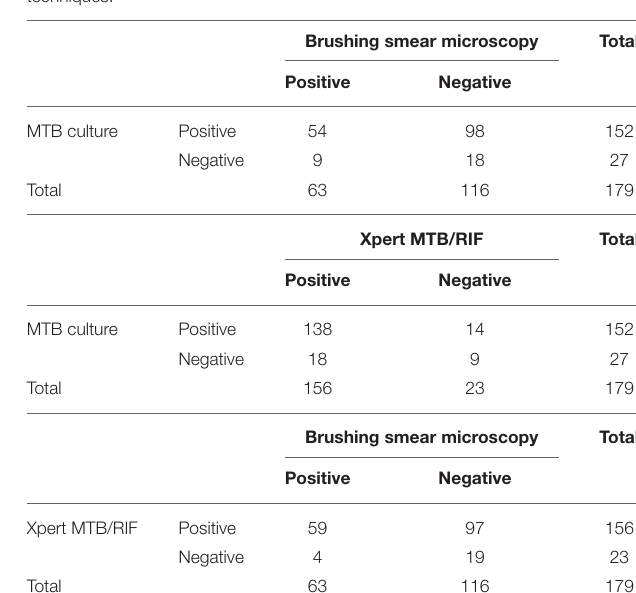
TABLE 3 | Comparison of diagnostic consistency of the different diagnostic